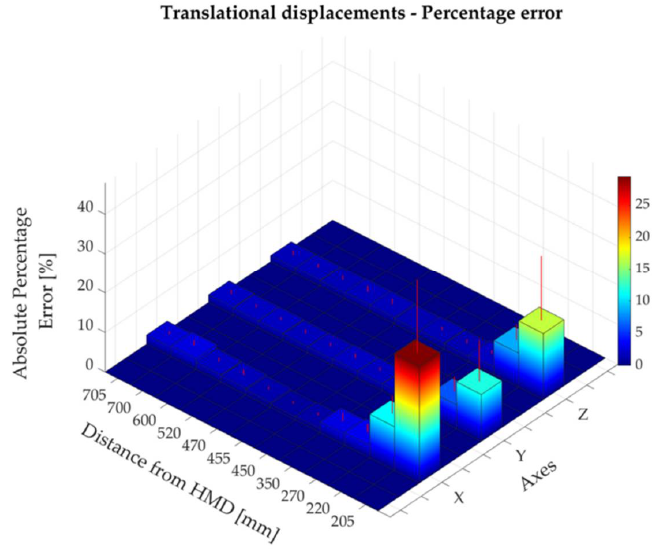
Figure 6. The percentage error along the x-, y-, and z-axes at different distances from the head- mounted display (HMD).